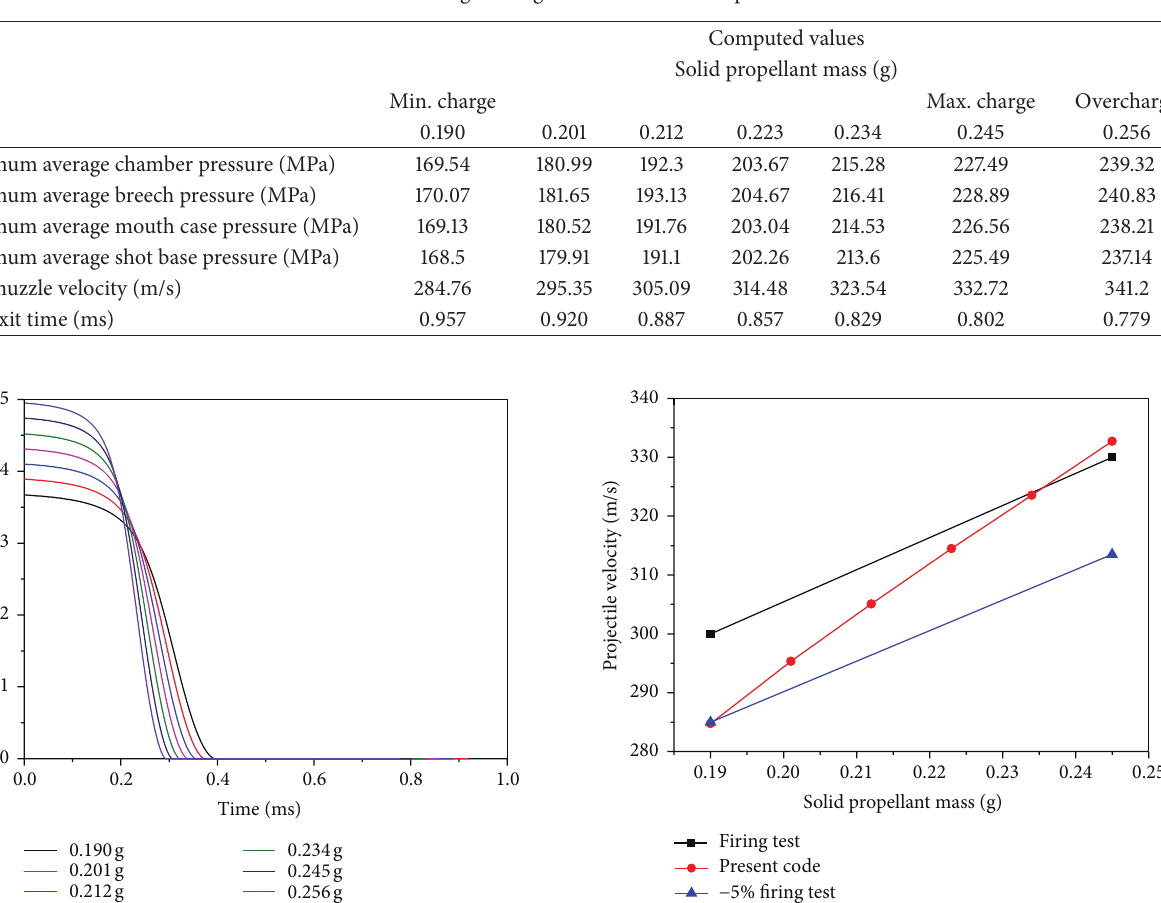
Table 3: Effect of weight charge on interior ballistic performance.